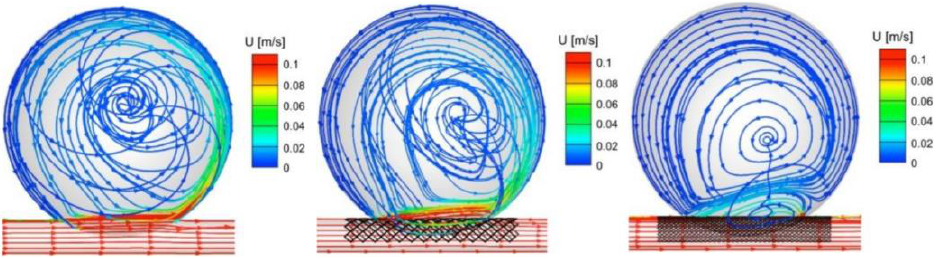
the struts of the stent affect the velocity flow field. Notice that in the outflow region of the the flow widens somewhat upward, showing the critical region where a risk of rupture may occur in aneurysms treated with stent devices. Figure 5. Velocity streamlines of the ( left ) UA, ( center ) RS, and ( right ) FD at peak systole. During the systole, the flow within the untreated aneurysm is characterized by a reg- ular vortex located at the center of the aneurysm, cf. Figure 5, with inflow at the distal and outflow at the proximal edge of the neck. After the treatment with the regular stent, the